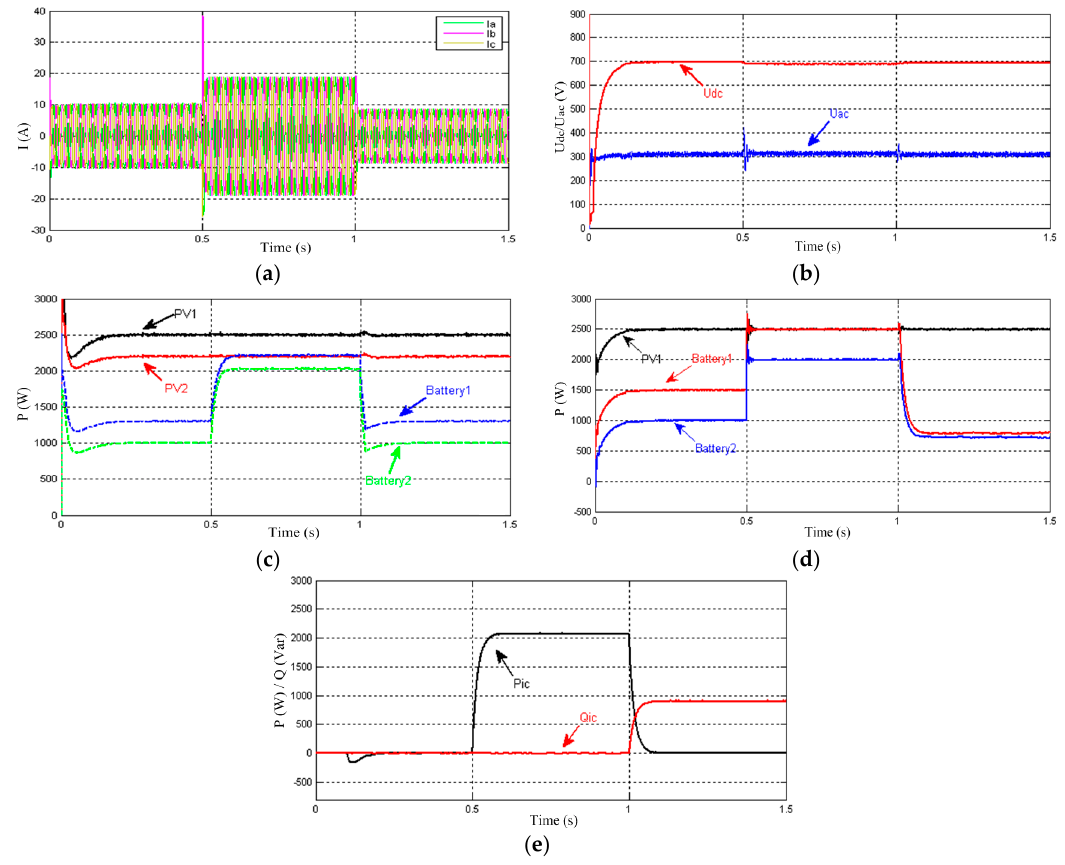
Figure 12. Simulated results of case 4: ( a ) the AC load varying current waveform; ( b ) DC and AC bus voltage; ( c ) output active power of units on the DC ‐ side; and ( d ) output active power of units on the AC ‐ side; ( e ) output active power and reactive power of IC.